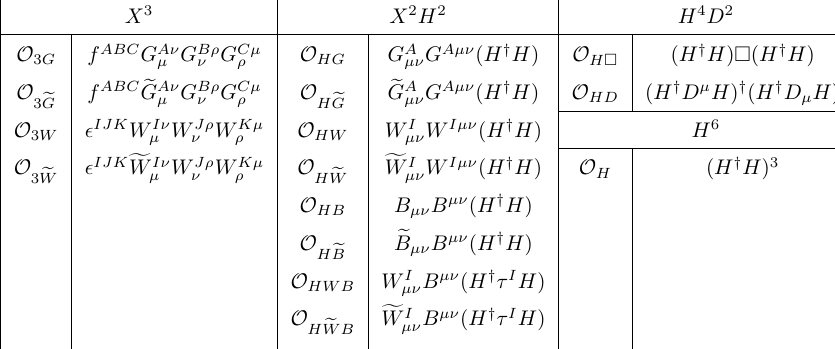
Table 7 . SMEFT bosonic operators.